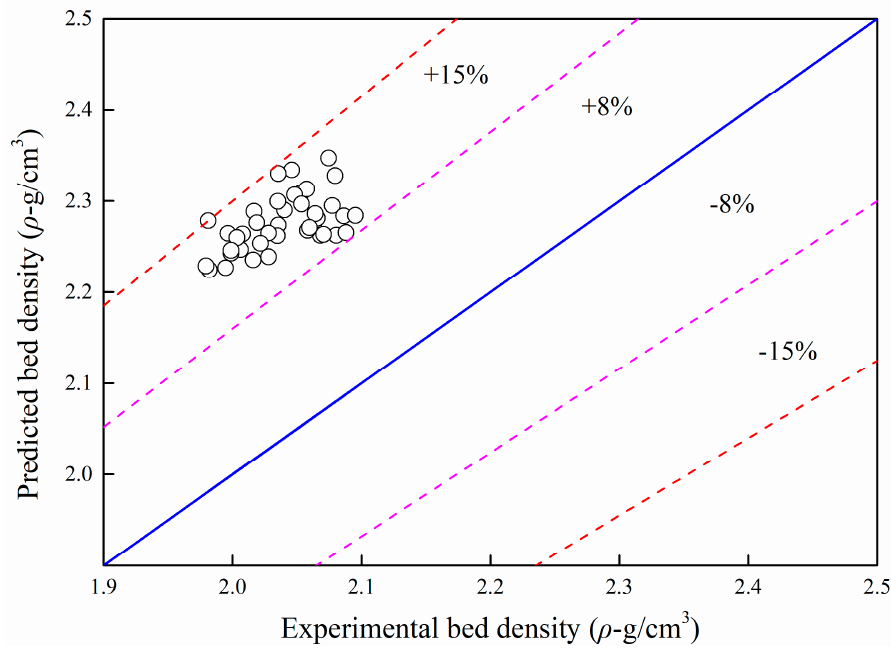
Figure 11. Error analysis in predicting the bed density of micron-sized particle.